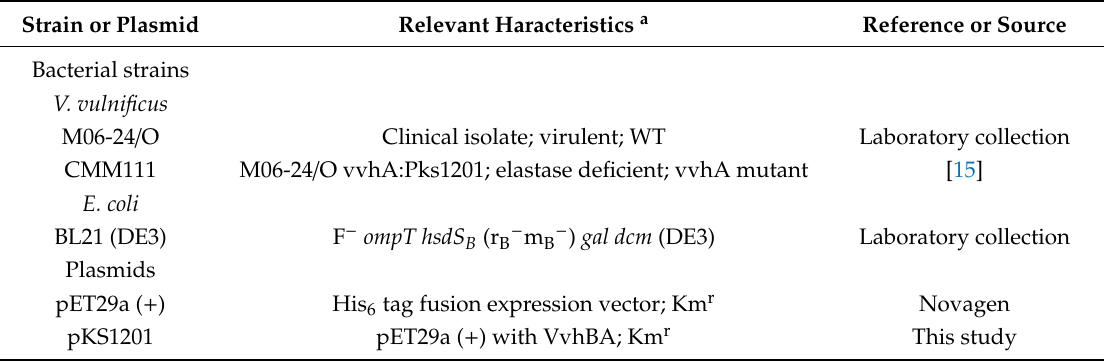
Table 1. Plasmids and bacterial strains used in this